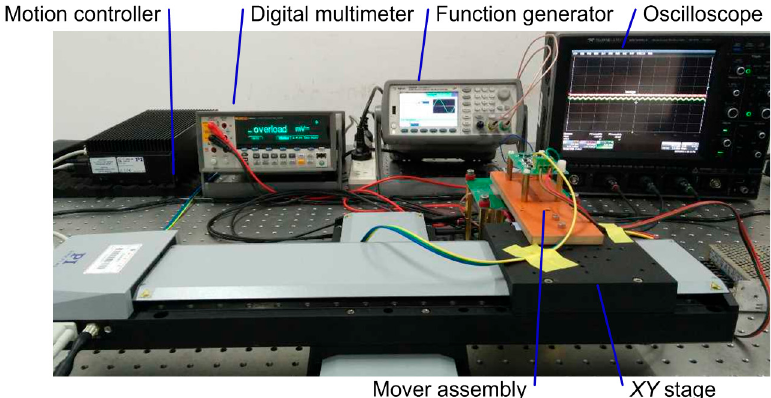
Figure 5. Configuration of the test bench.